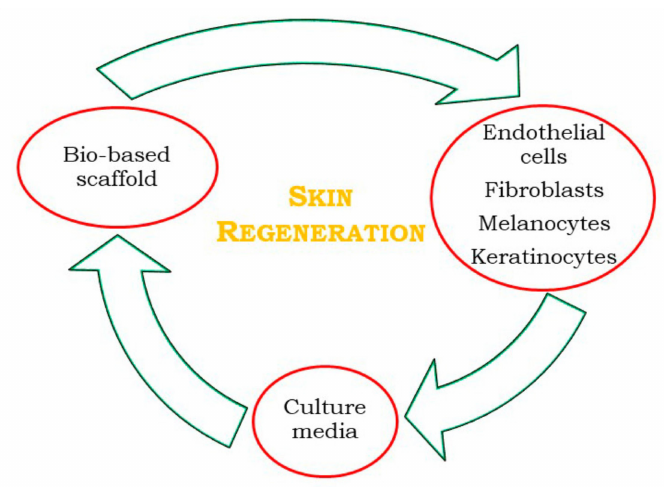
Figure 4. Skin regeneration (SR) process through tissue engineering (TE), adapted from Klar et al.